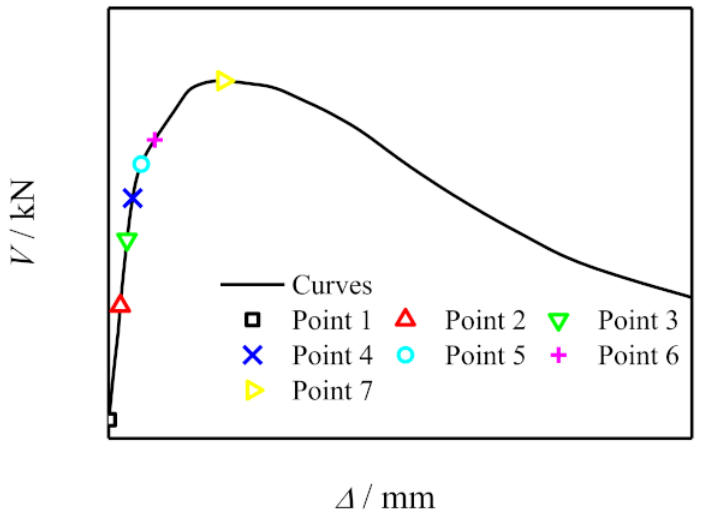
Figure 11. Typical V - ∆ curve of concrete-filled CFRP steel tube under shear